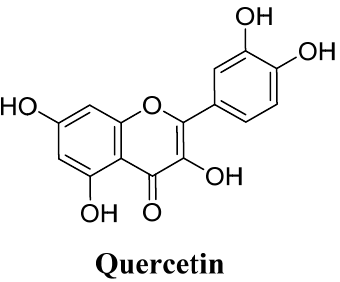
Figure 27. Quercetin. Figure 27.